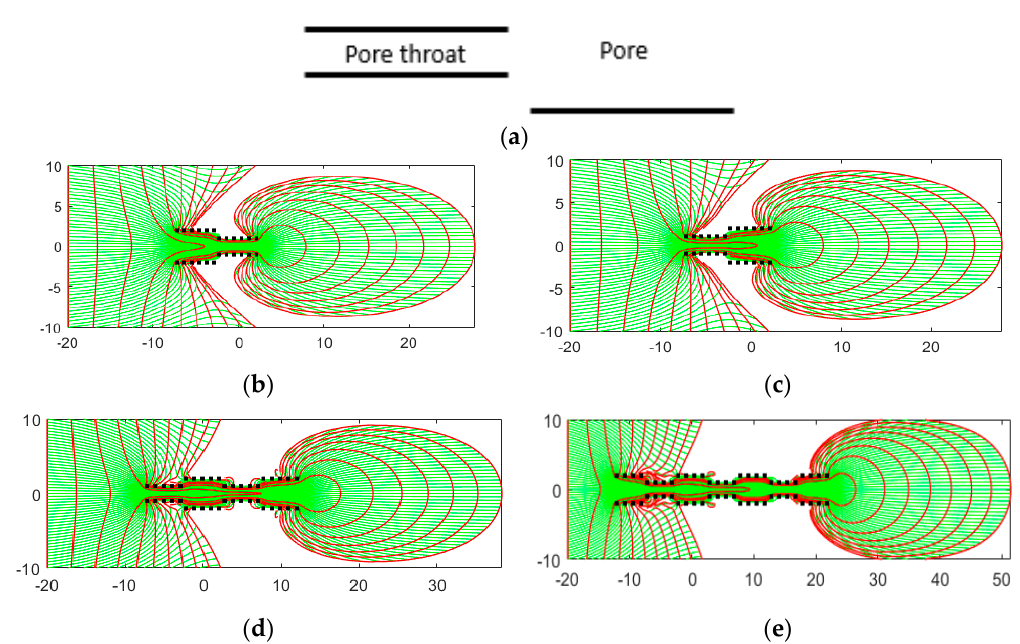
Figure 3. ( a ) Schematic of an elementary pore-model showing a pore and a pore throat. ( b ): Elementary pore-flow model comprised of array of various pores and pore-throats. Flow is represented by streamlines (green) and time-of-flight-contours (TOFC) (red), with spacing of 60 s. Total time-of-flight is 600 s, time step Δ t = 0.008 s. Height and width for pore-throat(s) is 2 × 10 − 6 and 5 × 10 − 6 m, respectively and for pore-spaces 4 × 10 − 6 and 5 × 10 − 6 m, respectively. The far-field flow velocity is 3.2 × 10 − 6 m/s. The strength of pore-throat and pore space is 10 − 18 m 4 /s, about 150 times the velocity of the far-field flow (after adjusting for unit dimensions). Length units are scaled in μ m (both x-axis and y-axis). ( c–e ) Same as ( b ) but with different arrangements of pores and pore throats.